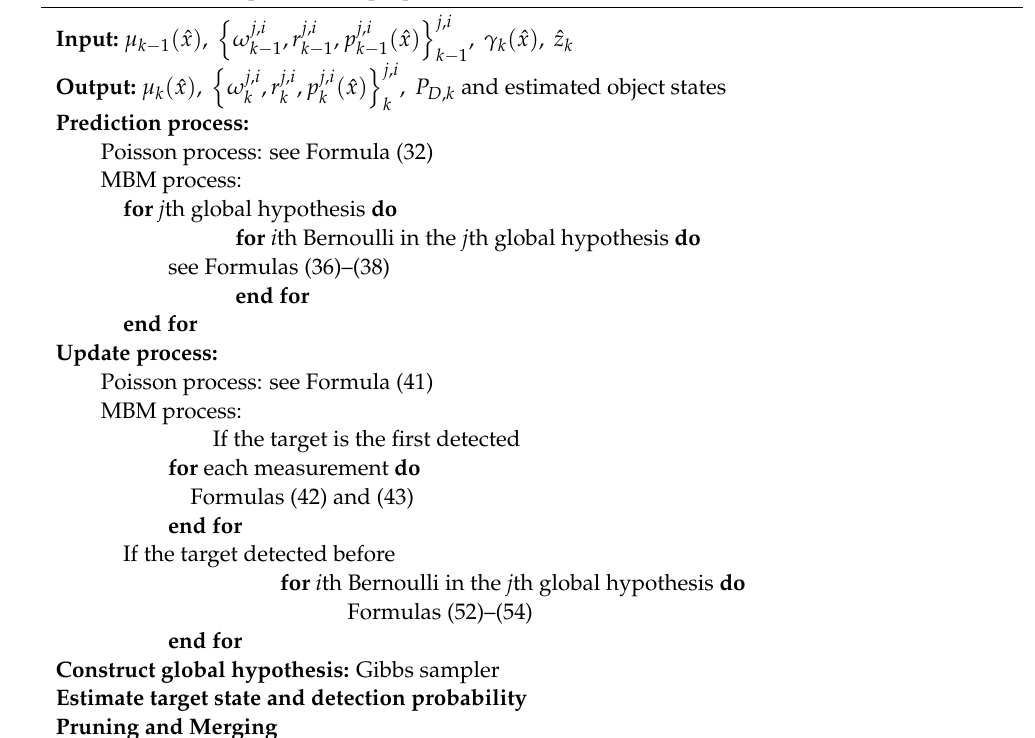
Algorithm 1 Description of the proposed robust